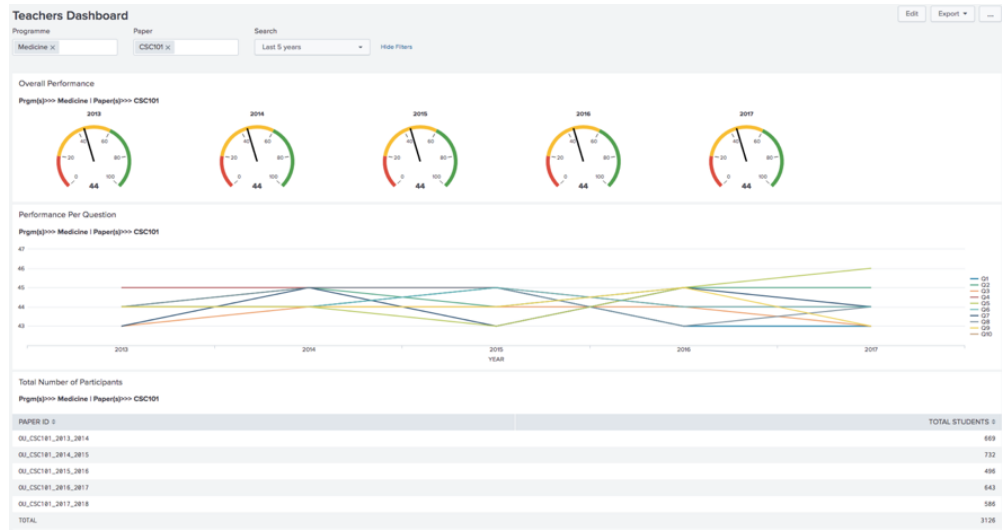
Figure 7. Performance of medicine students that participated in CS101 per year over five